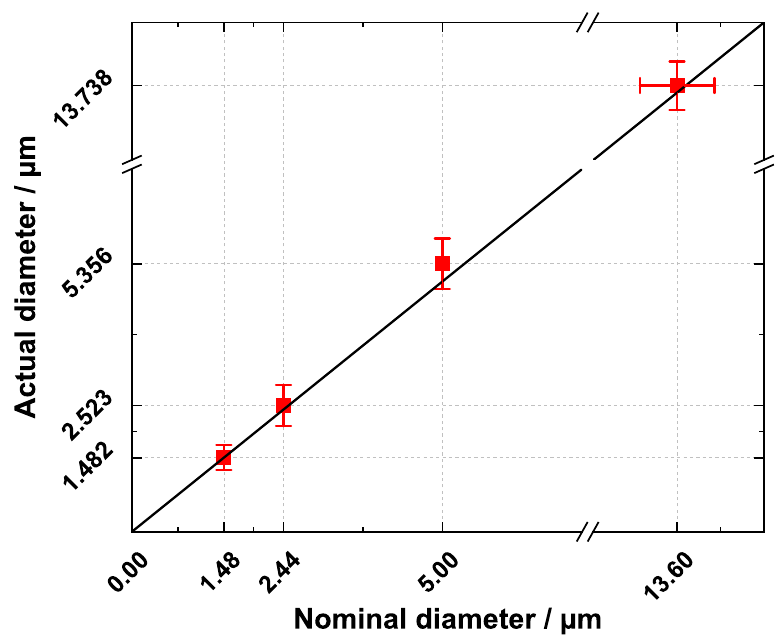
Figure 9. Comparison of nominal (manufacturer’s specifications) and actual fiber diameter (using the Dragonfly software) of the µ-CT scan. For each class more than 10 measurements have been